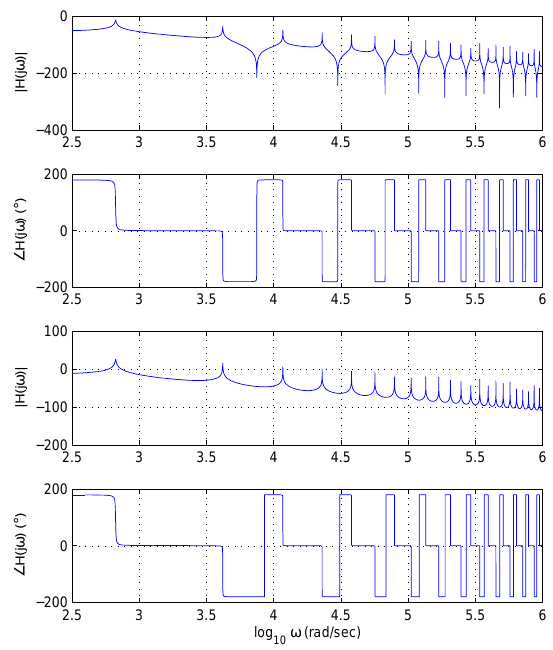
Figure 7. Bode plot of the response of the whisker shaft subjected to a distributed force. The first (top two panels) case has both resonances and anti-resonances, decreasing and increasing the phase response by 180 ◦ and 360 ◦ , respectively. The second case (bottom two panels) has only resonances. Sharp edges can be seen as phase changes from − 180 ◦ to 180 ◦ .